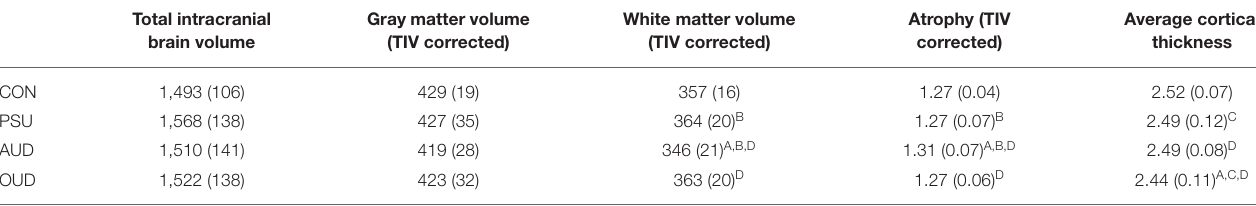
TABLE 2 | Total intracranial volume, global gray and white matter volume in cm 3 , and cortical thickness in